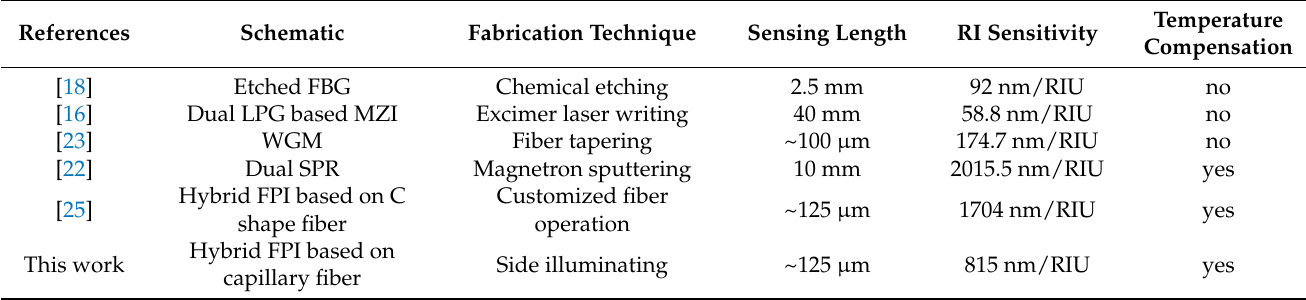
Table 4. Performance comparison with previously reported fiber RI